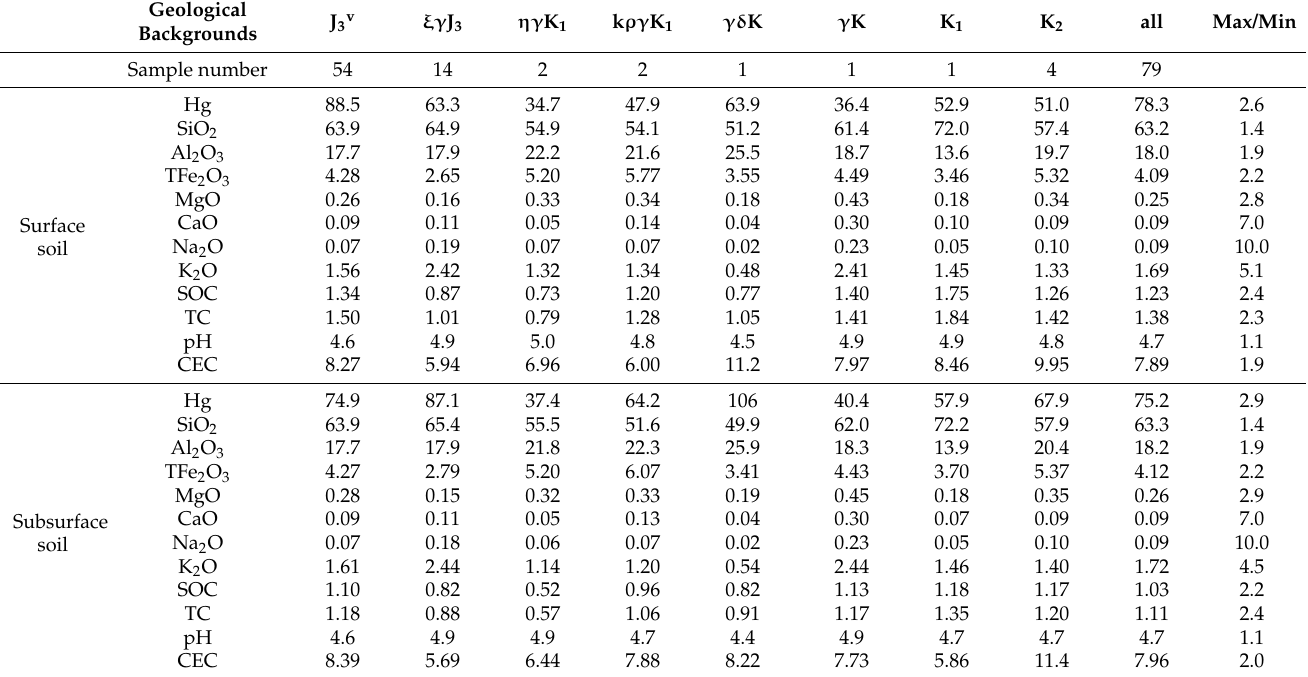
Table 8. Concentration of element/compounds and value of soil property in different geological backgrounds.